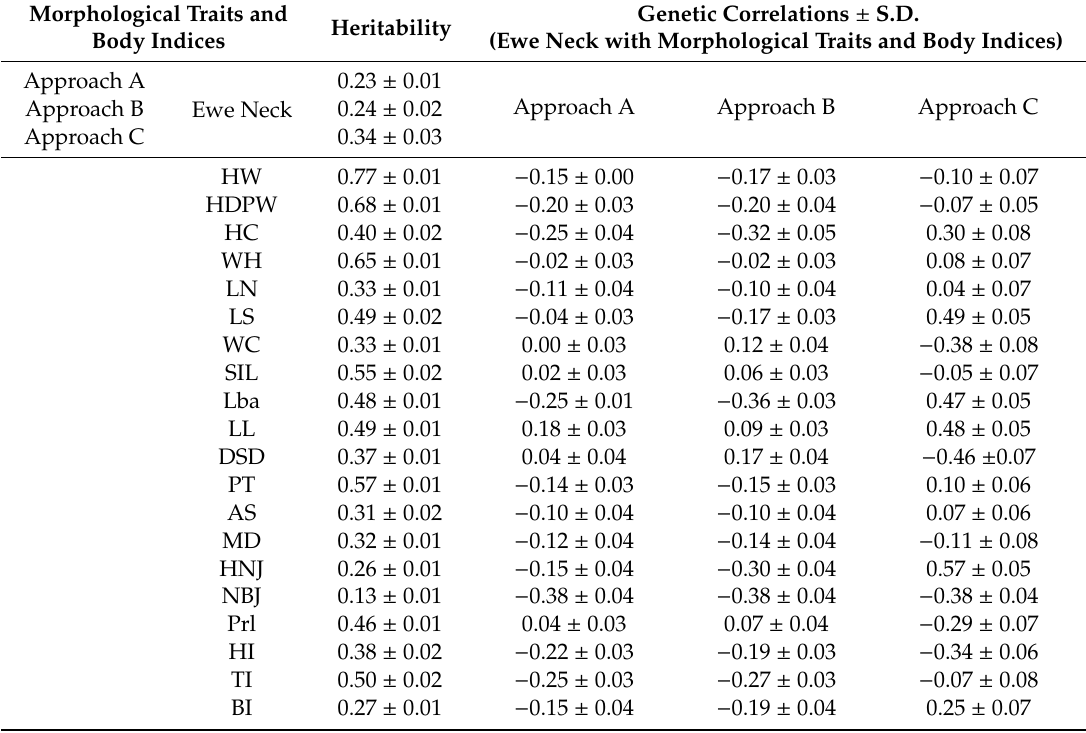
Table 5. Heritability and genetic correlations ± (s.d.) of Ewe Neck and morphological traits in the three complementary approaches (A, B, and C) in a population of Pura Raza Español horses. Morphological Traits and Genetic Correlations ±